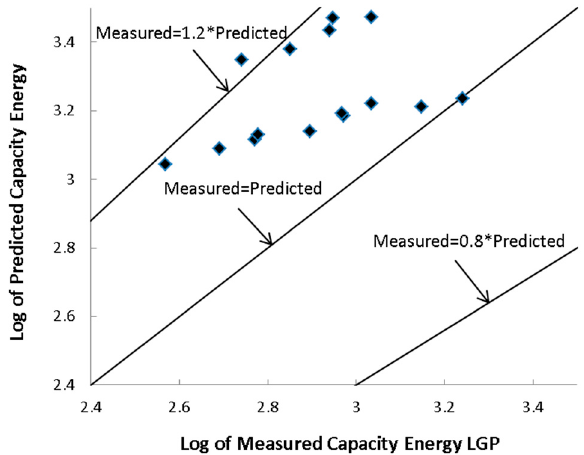
Figure 8. Capacity energy predicted by genetic programming (LGP) versus the measured values of